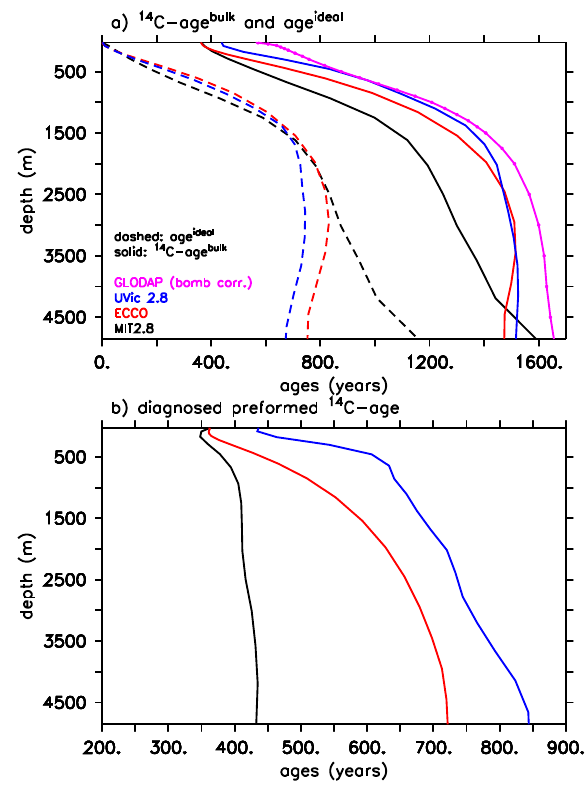
Figure 2. (a) Global mean profiles of bulk 14 C-age (solid lines) and ideal age (dashed lines) for three different global ocean circu- lation models (for colour code see figure insert) and the GLODAP database (solid magenta). (b) Global mean profiles of the difference between bulk 14 C-age and ideal age for three different global ocean circulation models (colour code as in a